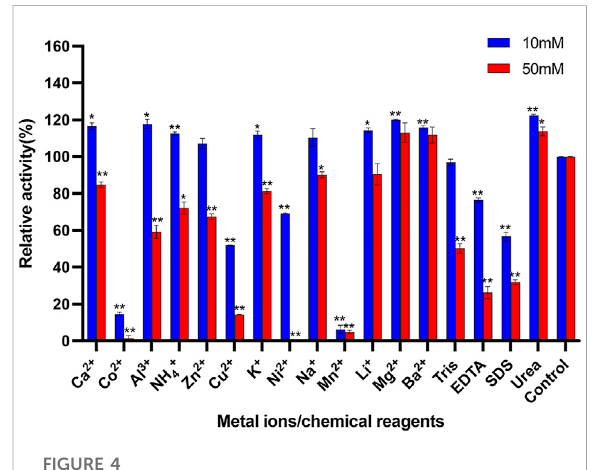
FIGURE 4 Effects of metal ions and chemical reagents on activity of Δ 30AfChiJ. Untreated enzyme was used as the control, and the activity of this preparation de fi ned as 100%. Experiments were carried out in triplicate, and standard errors are shown (mean ± SD). Asterisks indicate statistically signi fi cant differences from the control (Student ’ s t-test. *, p < 0.05; **, p < 0.01). Abbreviations: EDTA, ethylenediaminetetraacetic acid; SDS, sodium dodecyl